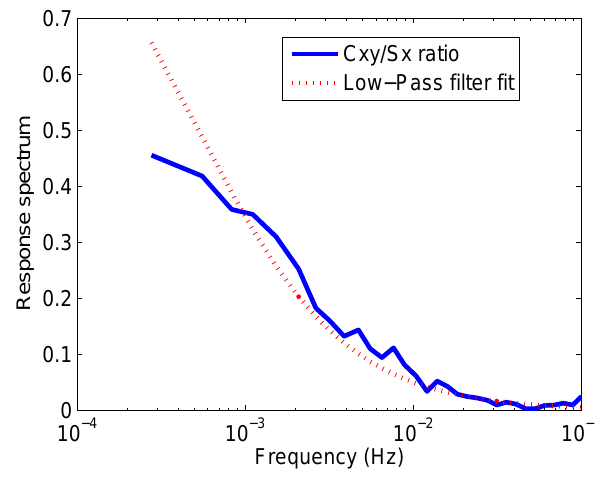
Fig. 11. Molar water vapor in ambient air during testing of the Nafion Dryer in Boulder. The noisier, upper time series data are from the LI-COR-7500 placed upstream of the Nafion system, and the lower signal is from the second, same type instrument down- stream of the Nafion dryer.